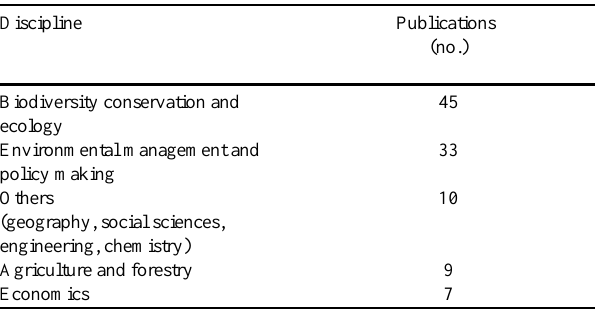
Table 1 . Number of publications according to the discipline of the first author. (For three of the authors, information regarding their disciplines was not available.)